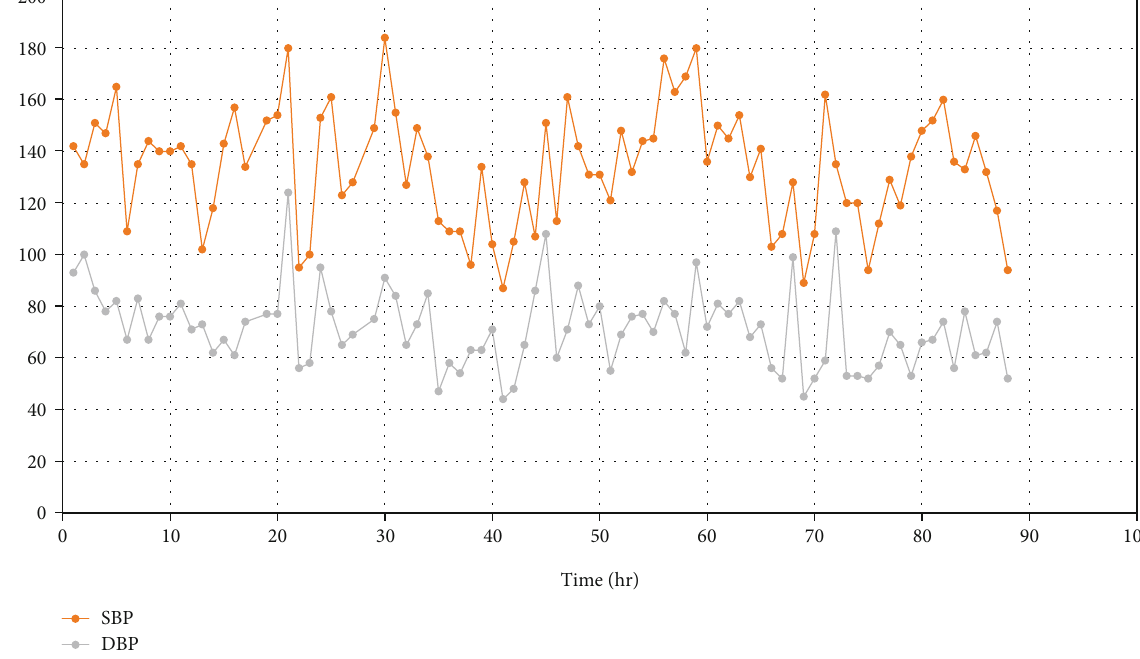
Figure 2: Blood pressure values monitored over a period of approximately 90 hours during hospitalization showing variations in an hour- to-hour readings of blood pressure. hr: hour; SBP: systolic blood pressure; DBP: diastolic blood